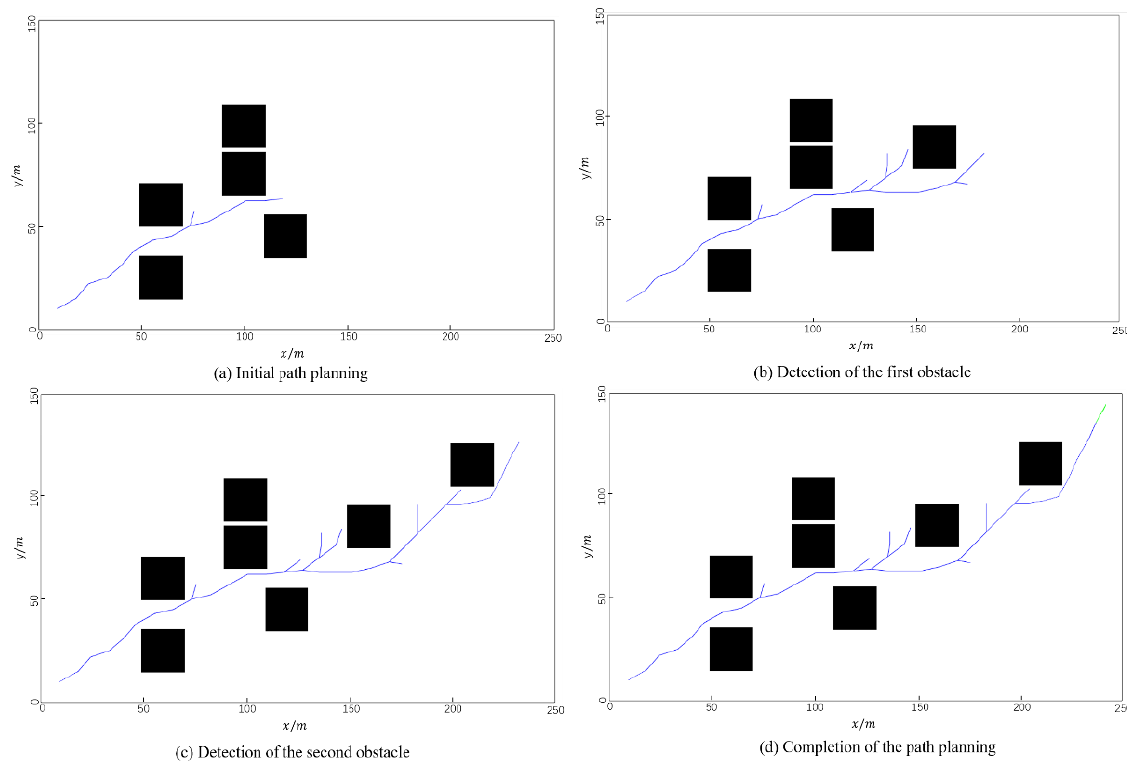
Figure 9. Path planning results with two random static obstacles in test environment M5.